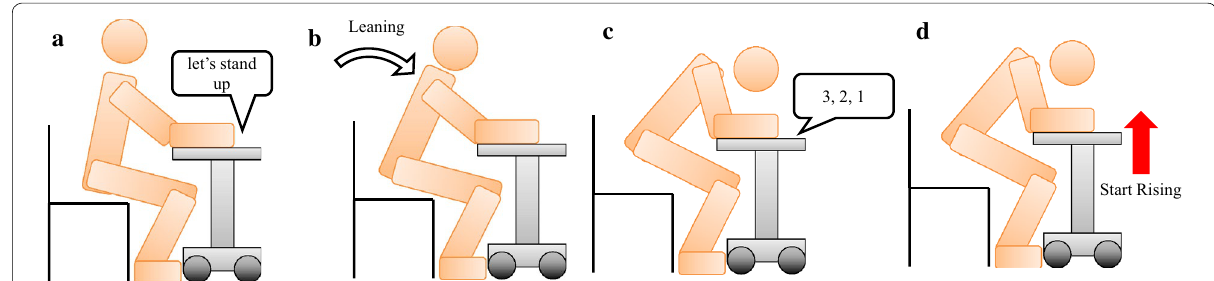
Fig. 6 Guidance and support procedure (pattern 14.) a Verbal guidance “let’s stand up” when user is sitting; b beginning of leaning; c verbal guidance “3, 2, 1” at end of leaning; d armrest start uprising after verbal guidance